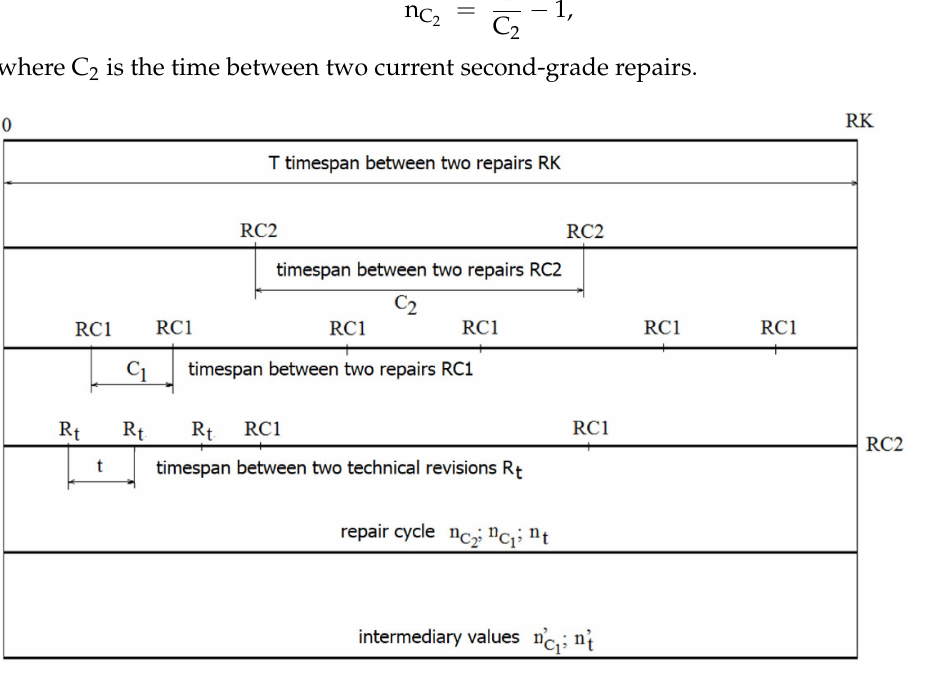
Figure 5. Scheme of the principle of the repair cycle for the technical revision system and planned periodic